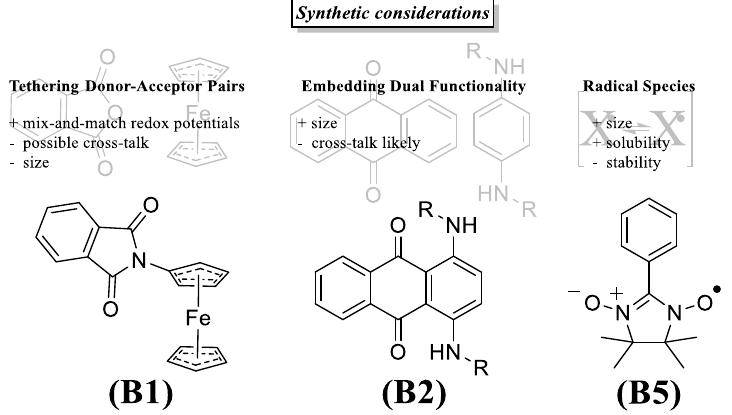
Figure 12. Strategies to attain electrolytes capable of anolyte and catholyte function simultaneously. The assigned acronyms ( B1 , B2 , B5 ) come from the structural overview of Figure